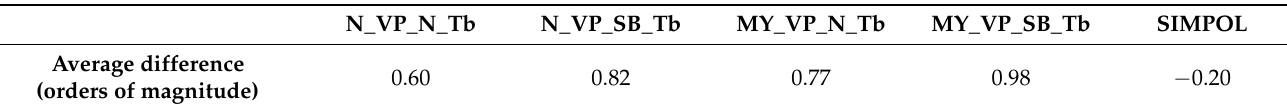
Table 5. Table showing the average difference between the experimental P sat et al. method [6], MY_VP is the Myrdal and Yalkowsky method [7], N_Tb is the Nannoolal et al. method [36], SB_Tb is the Stein and Brown method